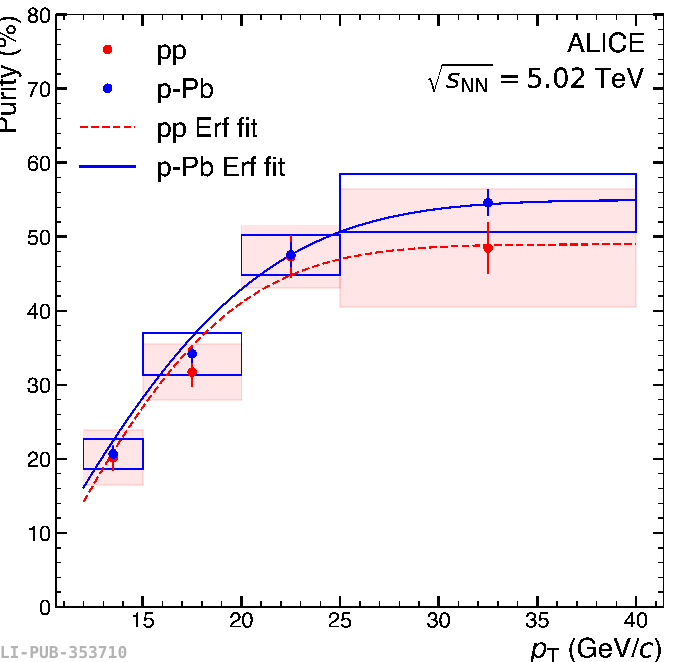
Figure 1. Purity of the isolated photon sample as a function of transverse momentum for pp and p–Pb data. The error bars represent statistical uncertainties only. The red shaded area represents systematic uncertainties in pp, the blue empty boxes represent systematic uncertainties in p–Pb